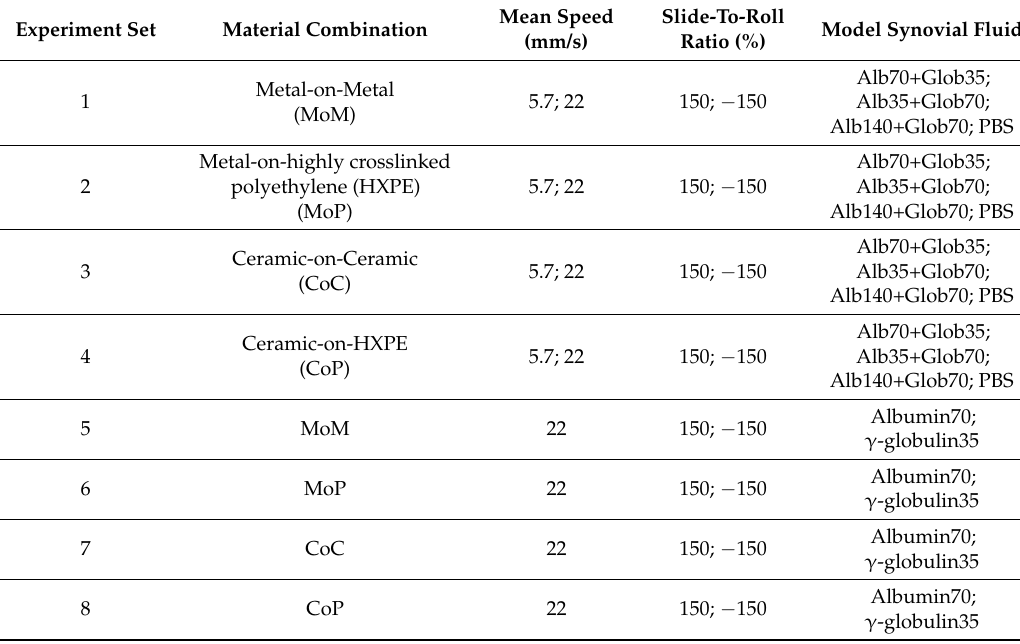
Table 3. Overview of the performed experiments.